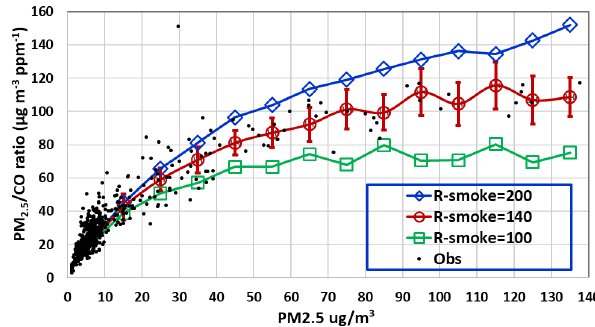
Figure 3. PM 2 . 5 / CO ratio (µgm − 3 ppm − 1 ) vs. PM 2 . 5 . The black dots show the observations, and the blue diamonds, red circles and green squares show the influence of the R smoke parame- ter for the urban + smoke simulations. The simulation results are binned in 10µgm − 3 intervals centered on the indicated values. For these Monte Carlo simulations, R urban is fixed at 40. Error bars show 1 σ in the middle simulation. One observation is not shown (PM 2 . 5 / CO ratio of 122 and a PM 2 . 5 concentration of 159µgm − 3 ).